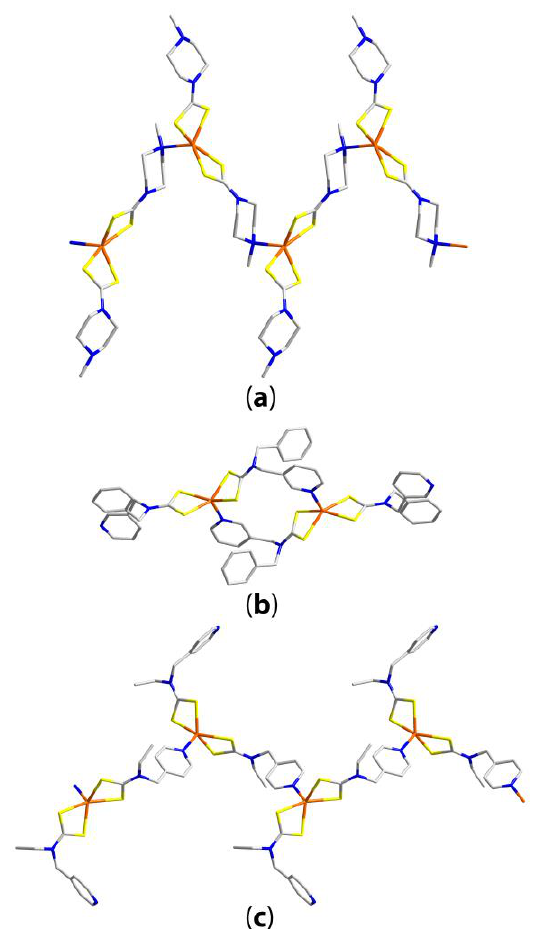
Figure 9. ( a ) One-dimensional coordination polymer in {Zn[S 2 CN(CH 2 CH 2 ) 2 NMe] 2 } n ( 96 ); ( b ) molecular structure of dimeric {Zn[S 2 CN(Benzyl)CH 2 (3-py)] 2 } n ( 97 ); and ( c ) one-dimensional coordination polymer in {Zn[S 2 CN(Et)CH 2 (4-py)] 2 } n ( 99